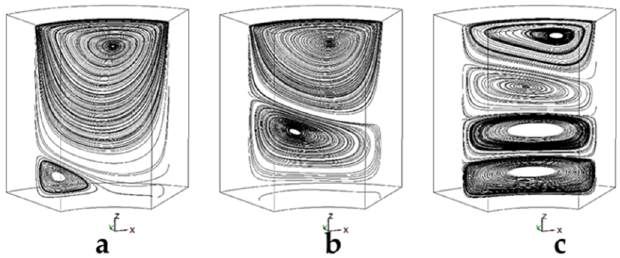
Figure 4. Streamlines of middle plane for different Rayleigh numbers at the Re = 100, φ = 0% and HR=2. ( a ) Ra = 1e4, ( b ) Ra = 1e5, ( c ) Ra = 1e6.